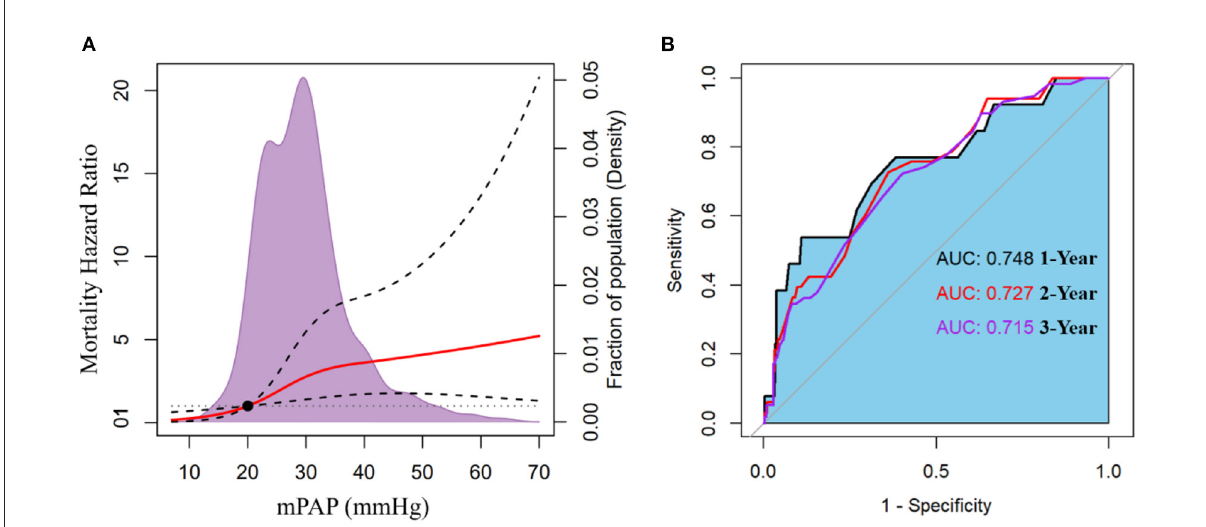
FIGURE3 (A) The adjusted hazard ratio for mortality according to mean pulmonary artery pressure (mPAP). (B) Receiver operator characteristic (ROC) curves with associated area under the curve (AUC) of mPAP to predict mortality at 1-, 2-, and